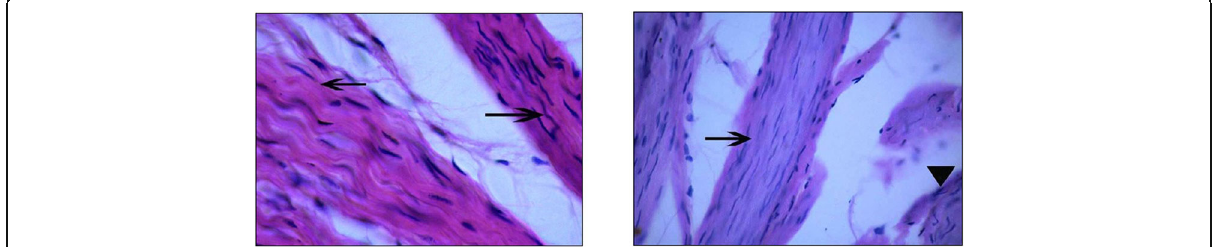
Fig. 4 Predominance of the oblique fibres in the upper and lower borders of the ring of the indirect umbilical hernia (the arrow points to the oblique fibres while the arrowhead points to the transverse